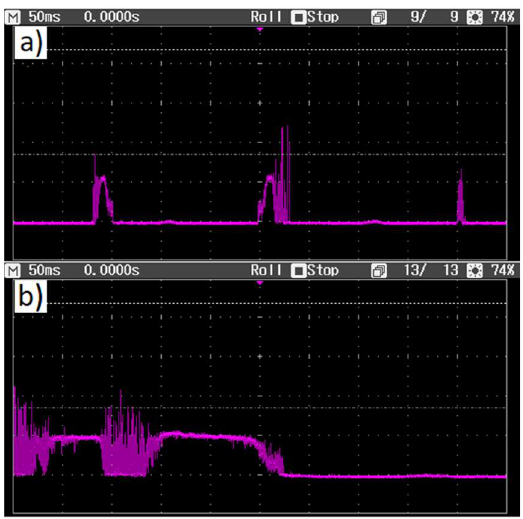
Fig. 5. Stokes output trace without self-injection (a) and with self-injection (b) . Timescale: 50 ms per division.